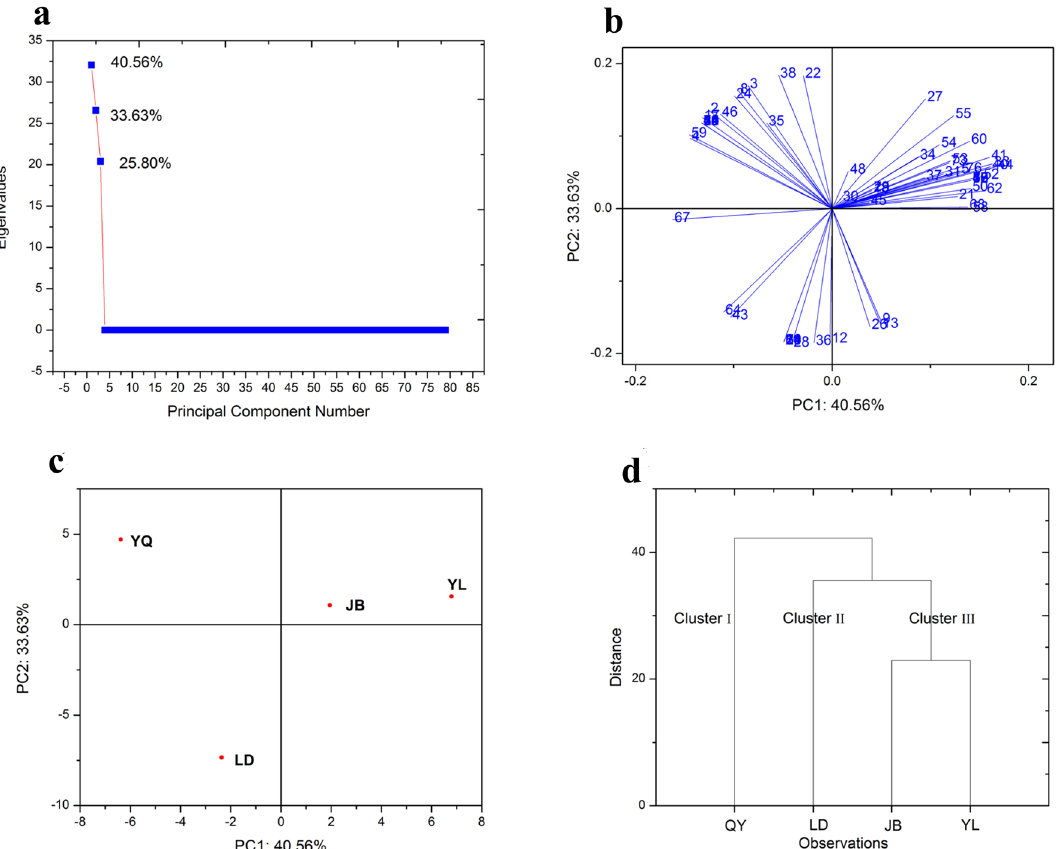
Figure 4. PCA and HCA plots of the thyme oil compositions from the four regions: eigenvalues of the correlation matrix ( a ); the loading plot of active chemical compounds ( b ); the score plot of the tested thyme oil ( c ); the corresponding dendogram ( d